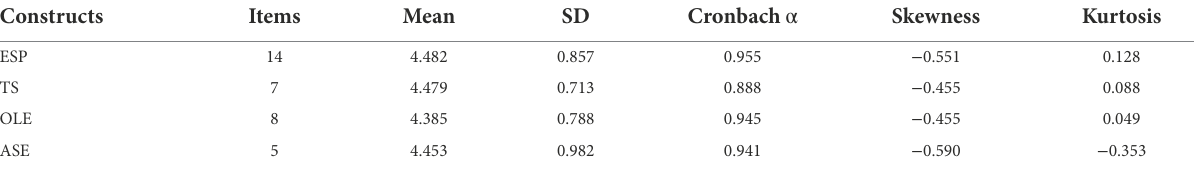
TABLE 2 Descriptive statistics of the study